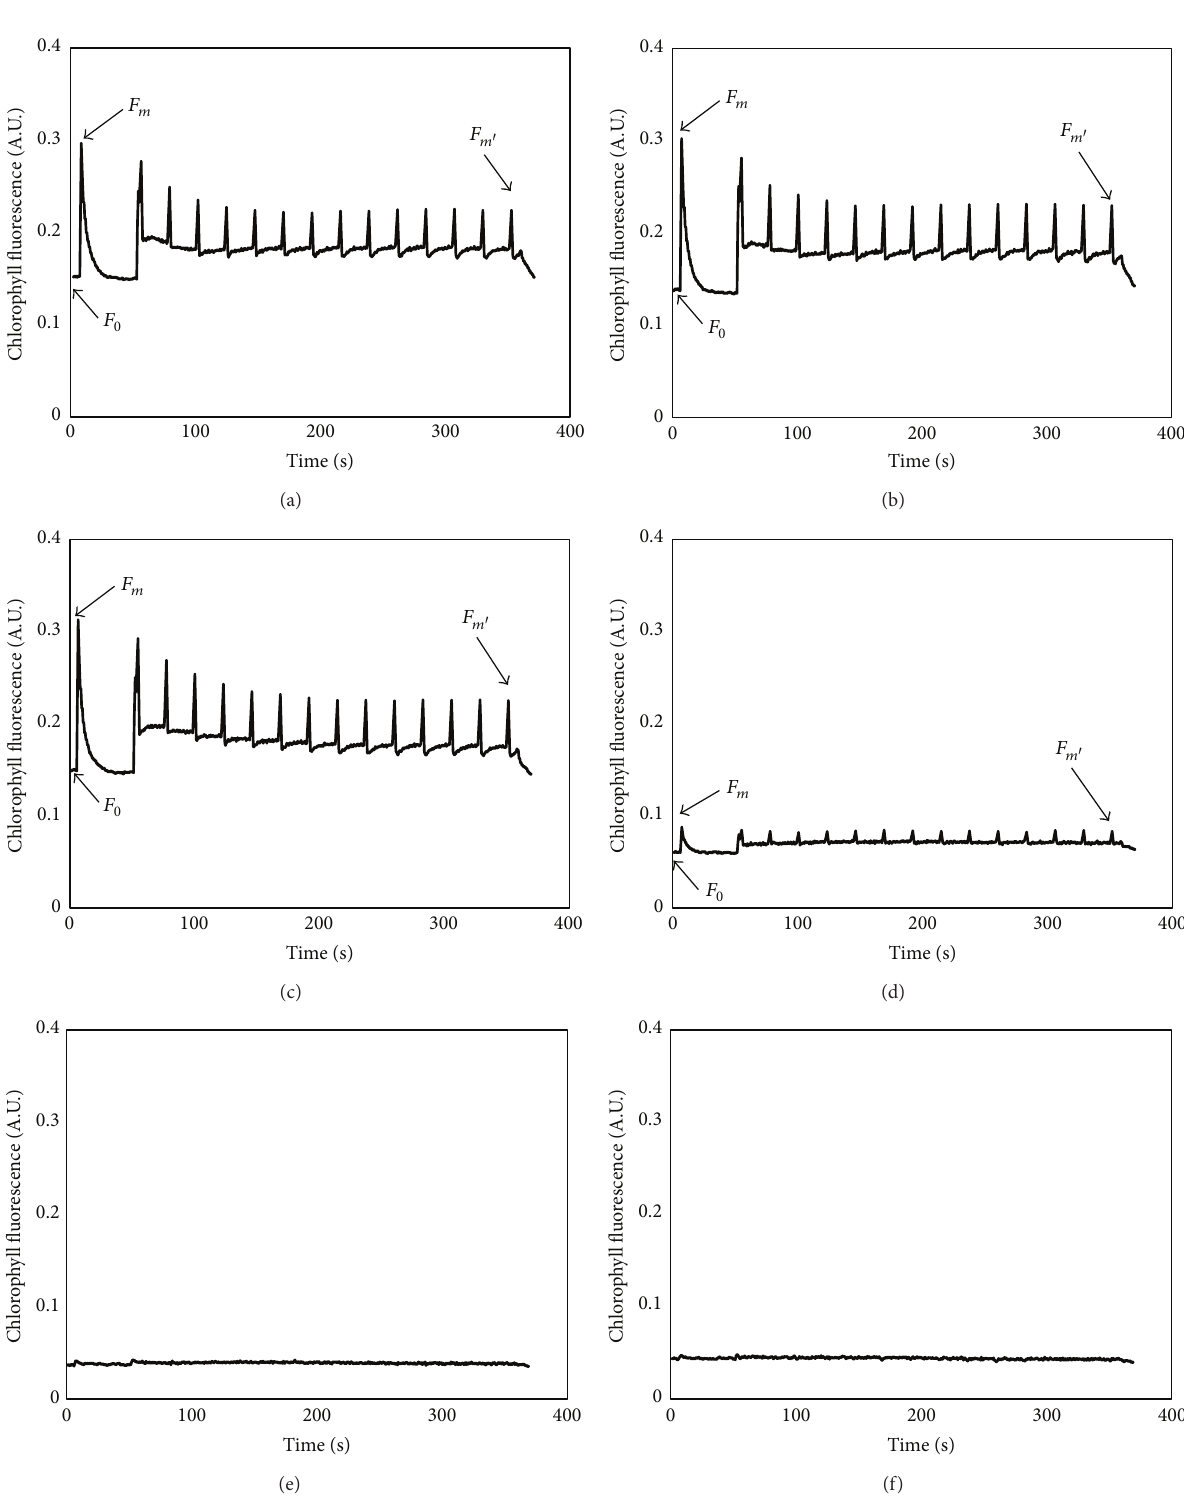
Figure 3: The photoinduced curves of Chlorella vulgaris after 96 h of exposure to ethyl cinnamate. ((a) Blank control, (b) 0.5 mg/L treatment, (c) 1mg/L treatment, (d) 2mg/L treatment, (e) 3 mg/L treatment, and (f) 4 mg/L